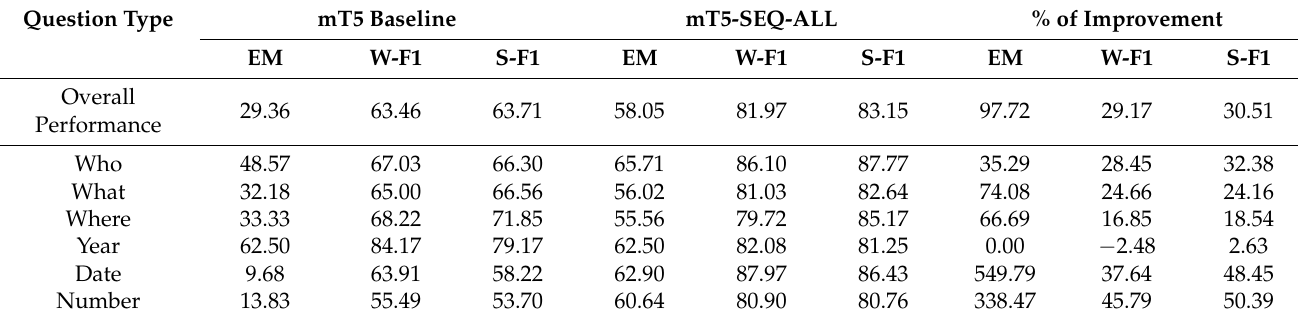
Table 10. Model performance evaluated on the iApp Wiki QA dataset classified by question types.